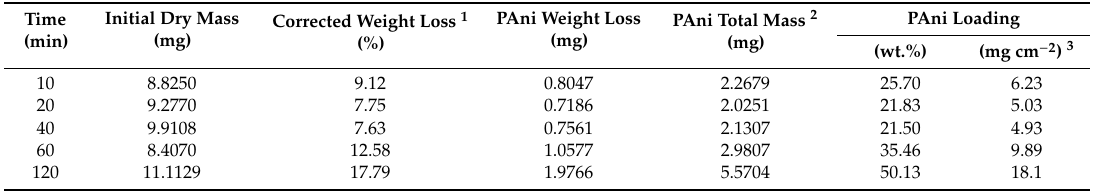
Table 2. PAniloadingsofdriedhybridPAni-ACCcompositessynthesizedafterdifferentelectropolymerization times.